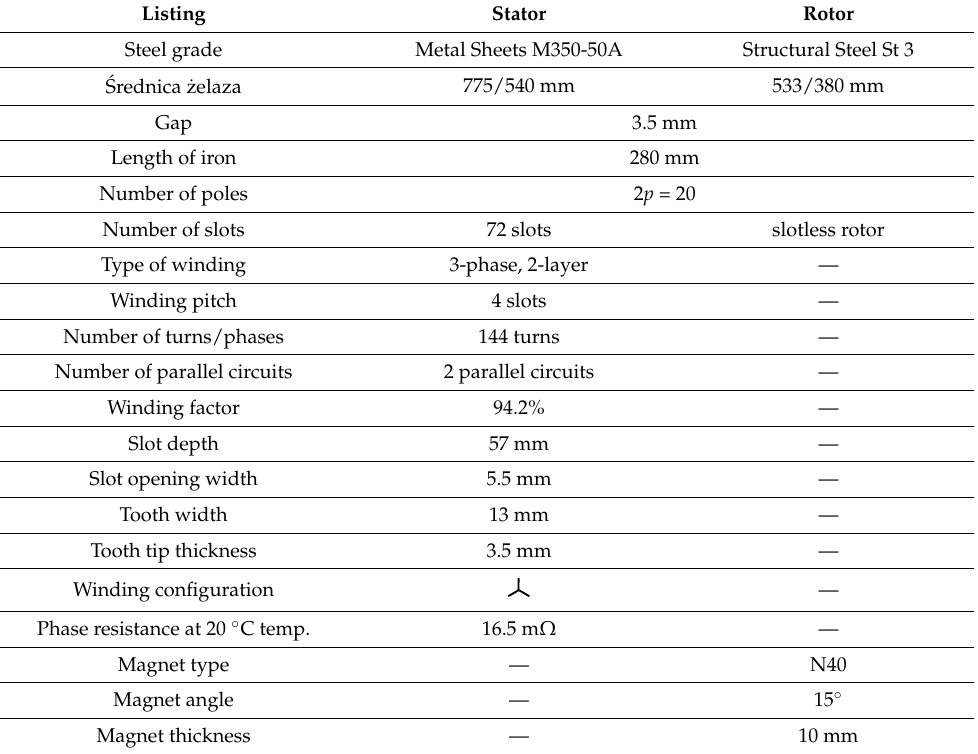
Table 2. Summary of the main design data of the generator.